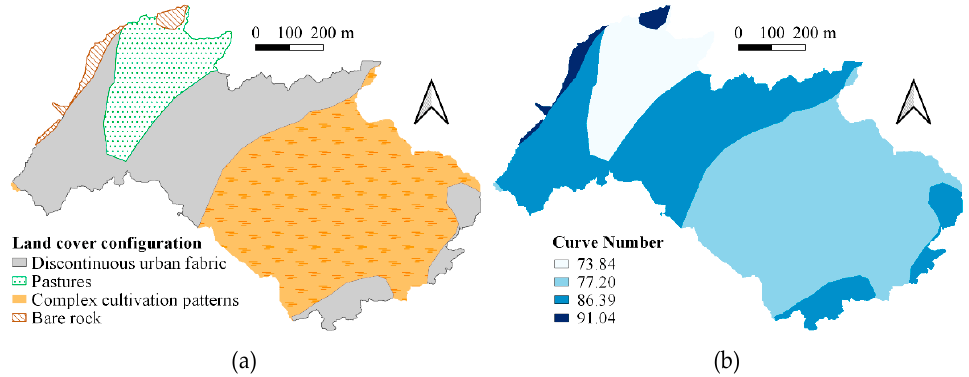
Figure 4 . (a) Land cover map of the Monte-Corbanera catchment. (b) Values of curve number asso- Figure 4. ( a ) Land cover map of the Monte-Corbanera catchment. ( b ) Values of curve number ciated with the types of surface in the study area. associated with the types of surface in the study area.